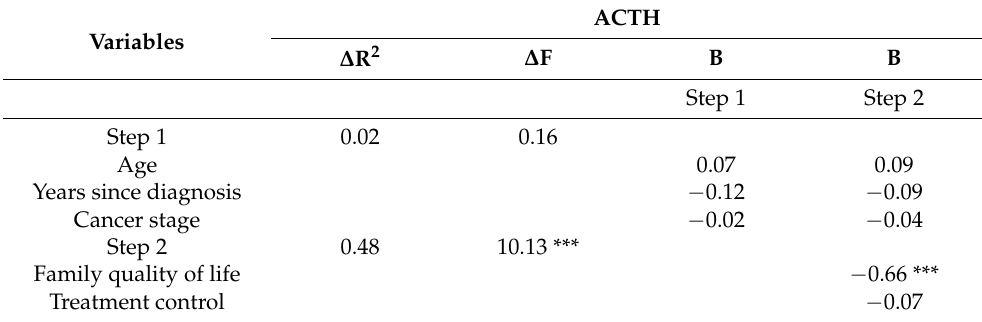
Table 6. The hierarchical regression analysis for the psychosocial factors predicting ACTH.